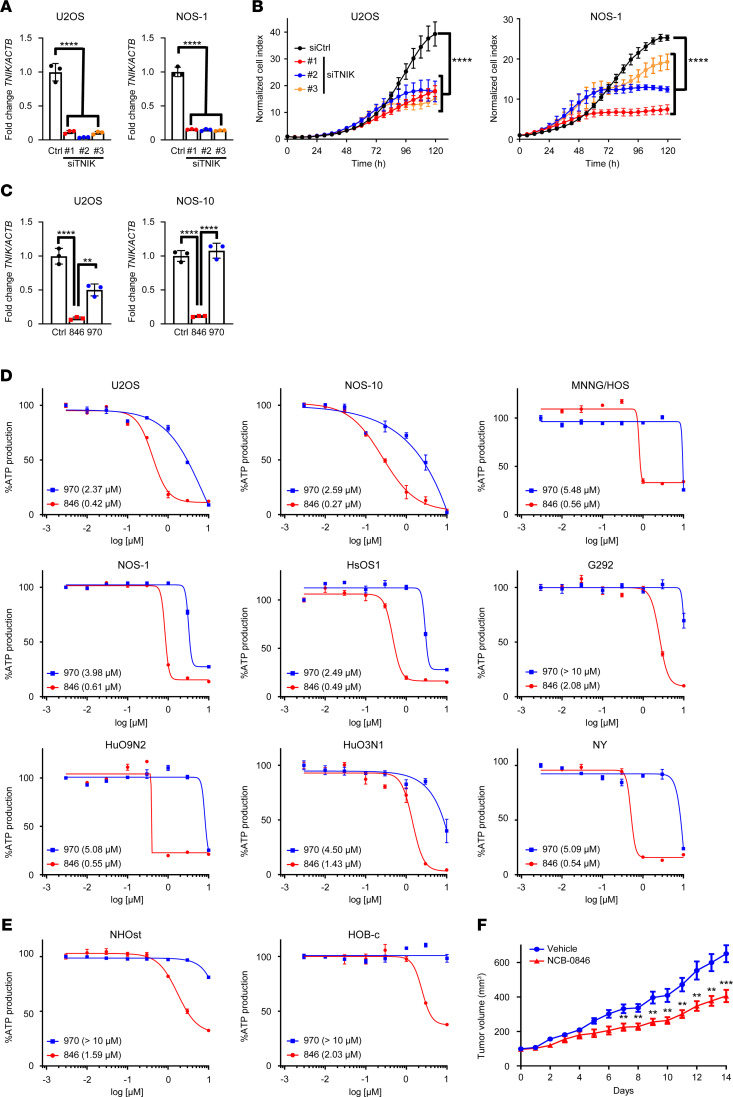
TNIK inhibition suppresses OS cell growth.(A) U2OS and NOS-1 OS cells were transfected with control siRNA (Ctrl) and siRNA against TNIK (siTNIK) in triplicate, and their expression of the TNIK gene (normalized to ACTB) was quantified by real-time RT-PCR. Data represent the mean ± SD of 3 replicates. One-way ANOVA, ****P < 0.0001. (B) Real-time growth monitoring of U2OS and NOS-1 OS cells transfected with control siRNA and siTNIK. Values at the time of transfection (0 hour) were set to 1. Data represent the mean ± SD of 4 replicates. One-way ANOVA, ****P < 0.0001. (C) The expression of TNIK (normalized to ACTB) in U2OS and NOS-10 cells treated with DMSO (Ctrl), NCB-0846 (846), or NCB-0970 (970) for 24 hours was quantified by RT-PCR. Data represent the mean ± SD of 3 replicates. One-way ANOVA, **P < 0.01, ****P < 0.0001. (D) Nine OS (U2OS, NOS-10, MNNG/HOS, NOS-1, HsOS1, G292, HuO9N2, HuO3N1, and NY) and (E) two osteoblast (NHOst and HOB-c) cell lines were cultured in the presence of 0.003–10 μM NCB-0846 or NCB-0970 for 72 hours, and their relative viability (IC50) was assessed in terms of ATP production. Data represent the mean ± SD of 3 replicates. (F) NOS-10 cells were inoculated into the subcutaneous tissues of 6-week-old female NOD/SCID mice. When the average volume of the xenografts reached 100 mm3, twice daily administration of water (vehicle, n = 10) or 80 mg/kg NCB-0846 hydrochloride (NCB-0846, n = 10) was initiated with a day off every 3 days and continued for a total of 15 days. Tumor growth and body weight in the vehicle group were compared with those in the NCB-0846 group at the same time points on a daily basis. Multiple t test corrected using the Holm-Sidak method, **P < 0.01, ***P < 0.001. Data represent the mean ± SEM.